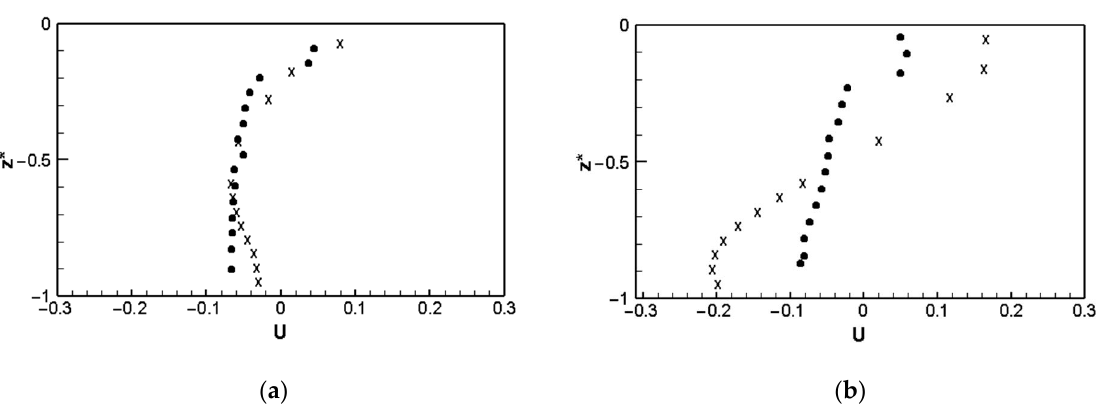
Figure 16. Result 6: undertow profiles in Configuration WKI, showing numerical results (X) and experimental results (circles) [3]. ( a ) 𝑥 = 7.27 m, ( b ) 𝑥 = 7.88 m , 𝑧 ∗ = (𝑧 − 𝜂̅)/𝐻(cid:3365) , and 𝑘 ∗ = (cid:3493)𝑘(cid:3364)/(𝑔𝐻(cid:3365)) ; 𝑧 ∗ = (𝑧 − 𝜂̅)/𝐻(cid:3365) and 𝑈 = 𝑢(cid:3364)/(cid:3493)(𝑔𝐻(cid:3365)) .